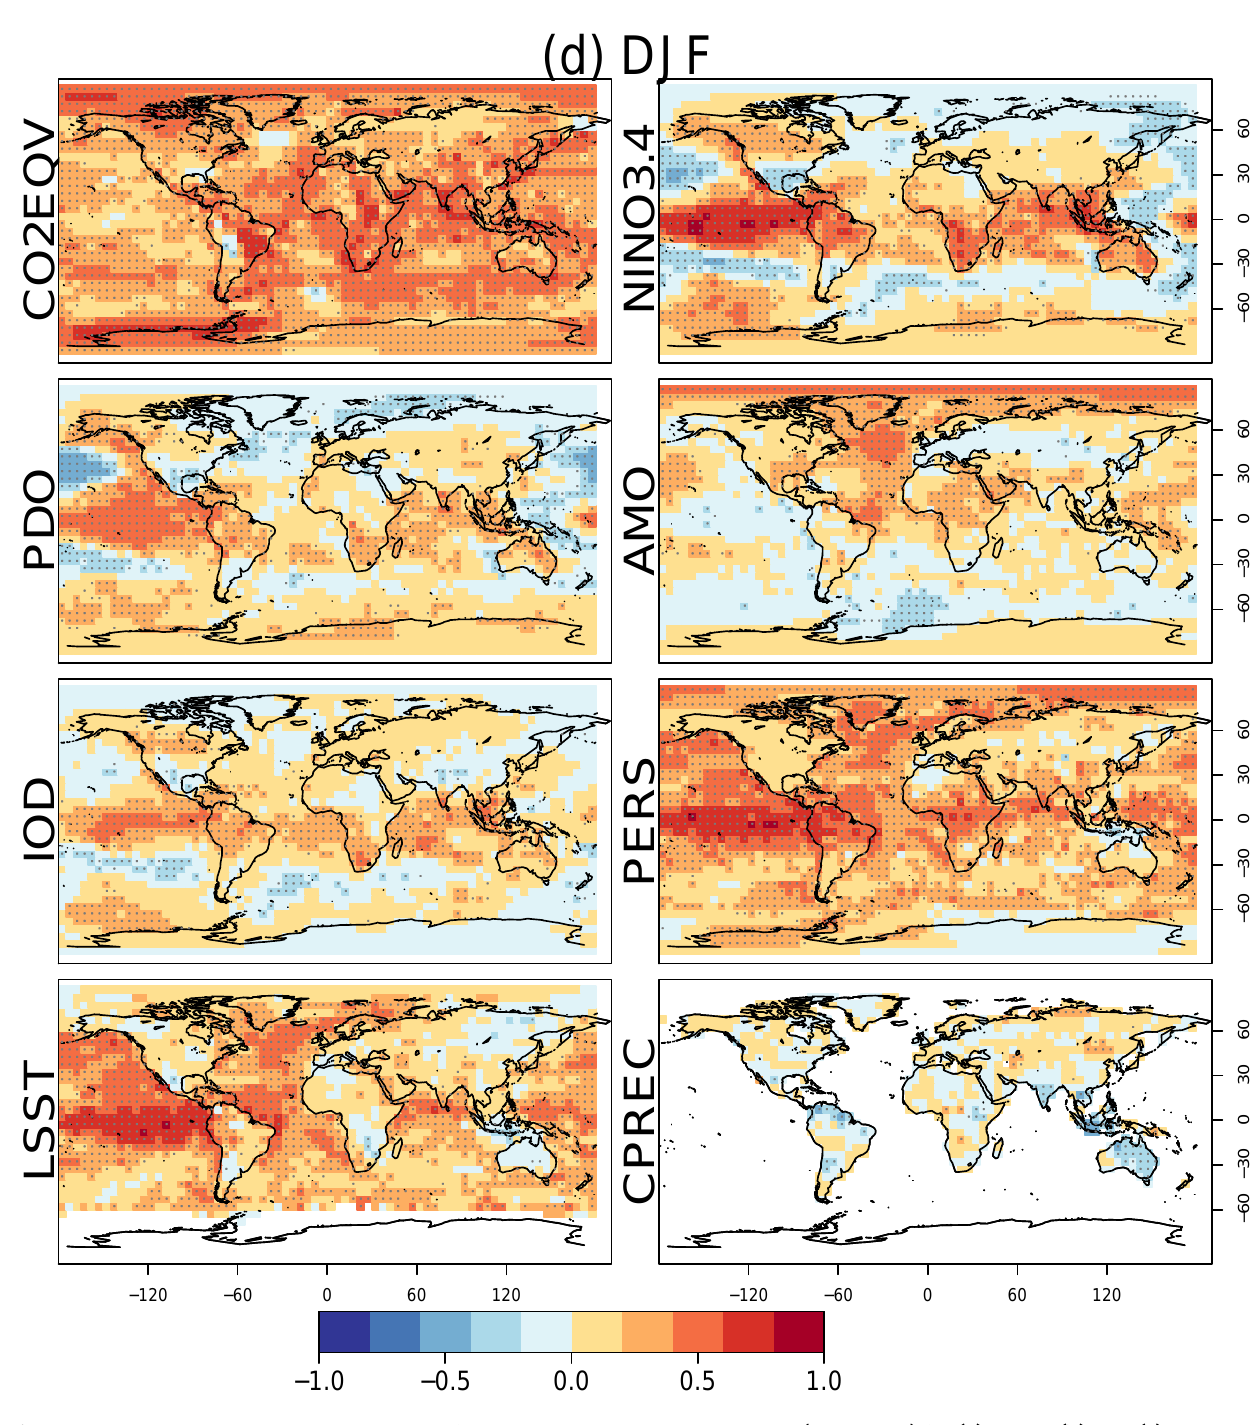
Figure 1. Correlation between SAT and the set of predictors with a 1 month lead time (1961–2013) for (a) MAM, (b) JJA, (c) SON, and (d) DJF. Correlation between CO2EQV is shown in the top left panel; subsequent panels show correlation between predictand–predictor pairs following removal of the CO2EQV trend. Stippling is used to indicate significance at the 95%